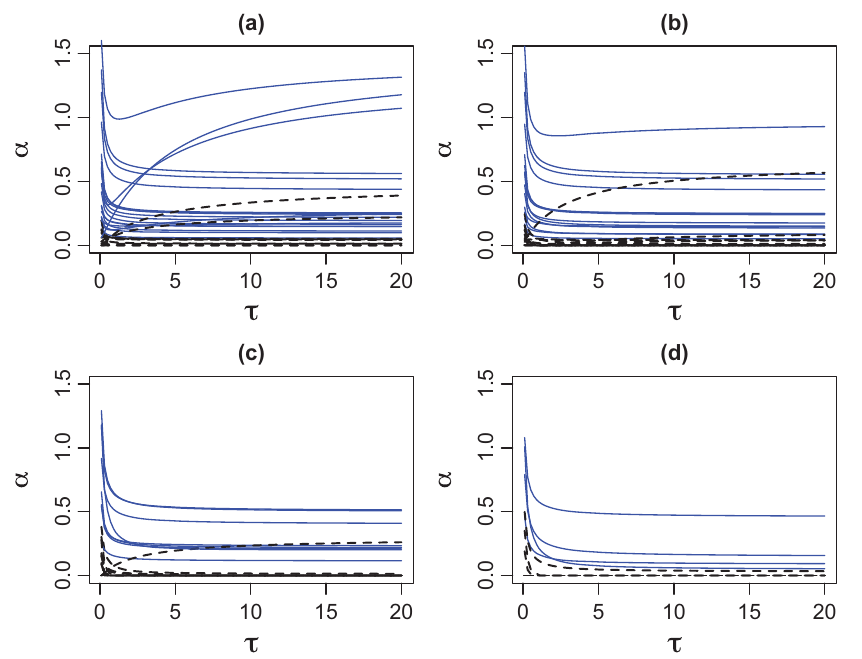
Figure 4: Economic growth data: The plot of the estimated parameters using the proposed method given different values of parameter 4 .